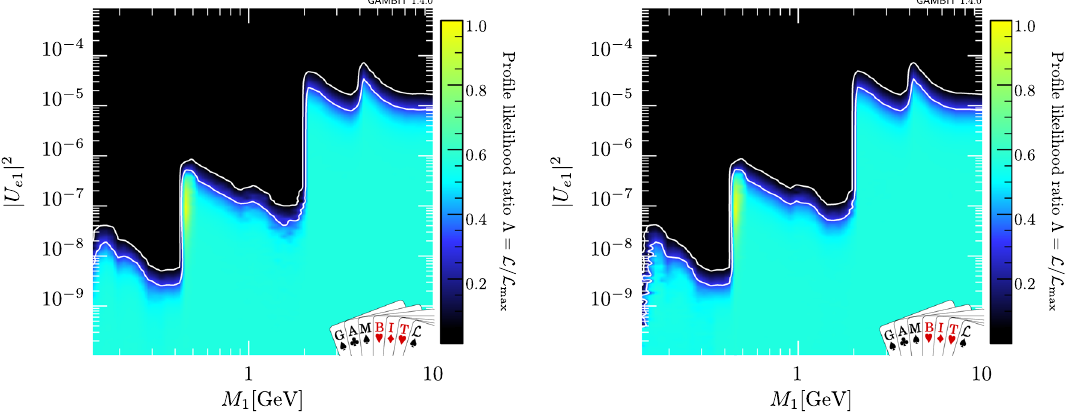
Fig. 17 Profile likelihood in M 1 vs U 2 plane without likelihood cap showing the excesses due to the R K constraint, for normal (left) and inverted e 1 hierarchy